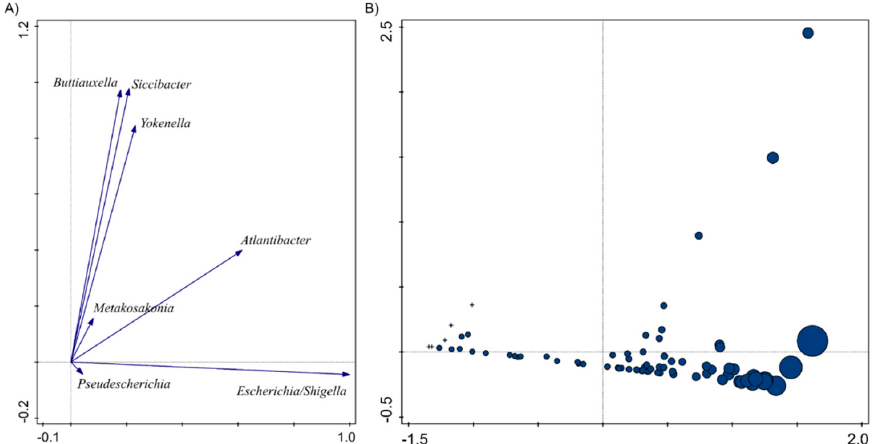
Figure 4. Principal component analysis (PCA) of sampling sites according to the abundance of the Enterobacteriaceae genera. The panels show genera according to their occurrence in ST samples ( A ) and sample ordering according to genera contribution ( B ). In panel B, symbol size is indicative of the Escherichia/Shigella abundance in each sample. The percentages of explained variation by the first and the second axes are 82.56 and 17.02%, respectively.